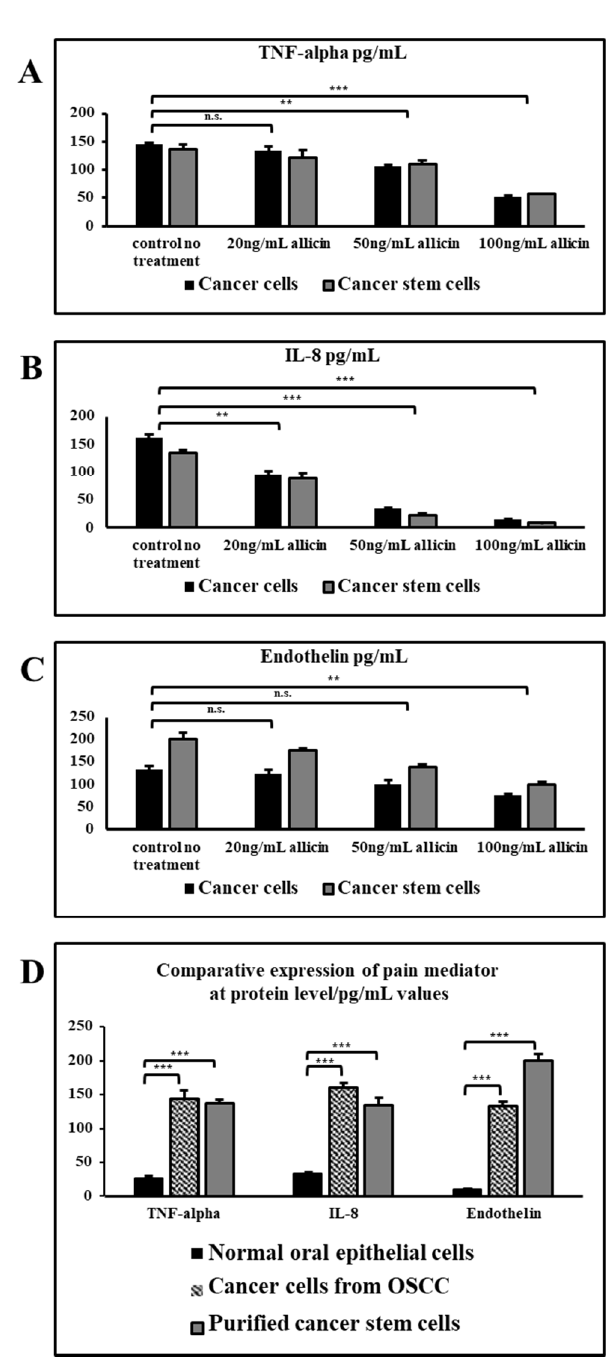
Figure 4. ELISA was performed to measure the secretion levels in pg/mL of pain mediators TNF- α , IL-8, and endothelin. ( A ) Protein levels of TNF- α . ( B ) Protein levels of IL-8. ( C ) Protein levels of Endothelin. ( D ) Comparative expressions of pain mediators at protein level in pg/mL values. n.s. not significant, ** p < 0.05, *** p < 0.01.